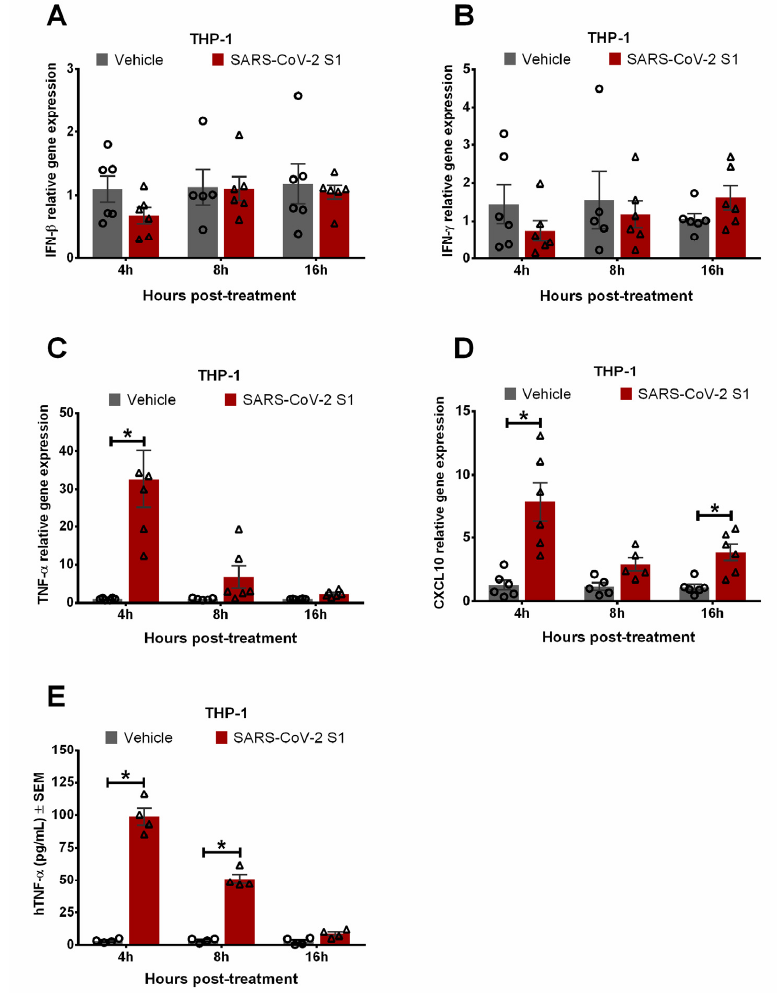
Figure 1. SARS-CoV-2 soluble, glycosylated spike protein S1 subunit (S1) induces a pro-inflammatory response in human THP-1 macrophages. THP-1 cells were treated with purified, recombinant, soluble S1 protein (0.6 µ g/mL, 8 nM) or vehicle for the indicated times. RT-qPCR was used to